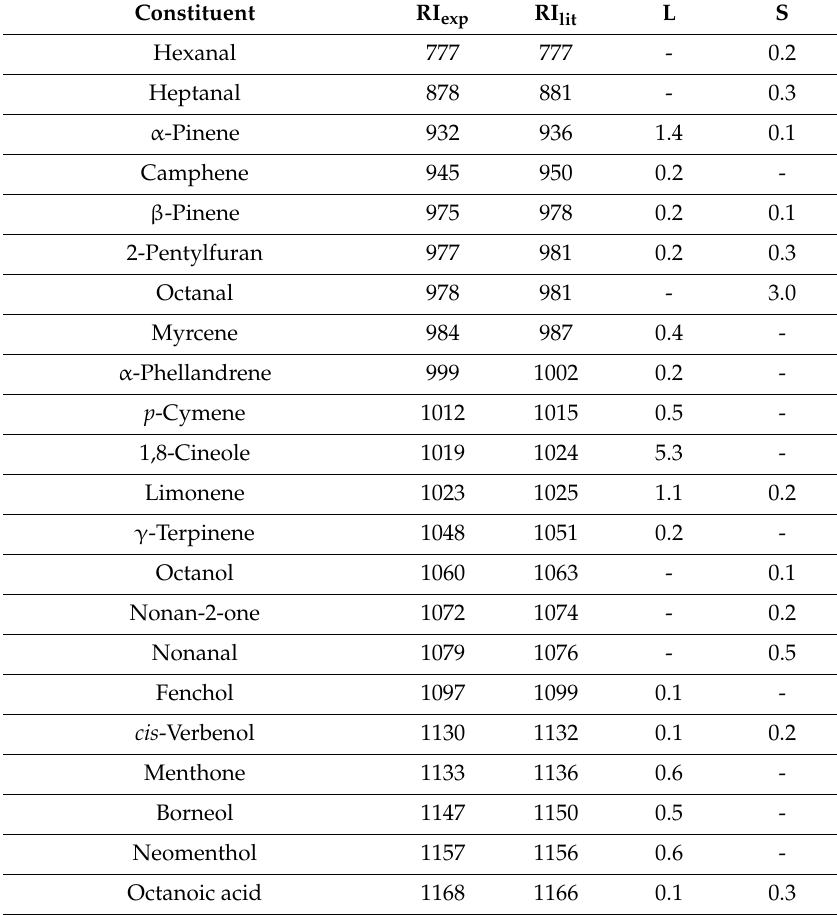
Table 2. The chemical composition (%) of the essential oil from basal leaves of the intact plant and in vitro shoot culture of E. alpinum